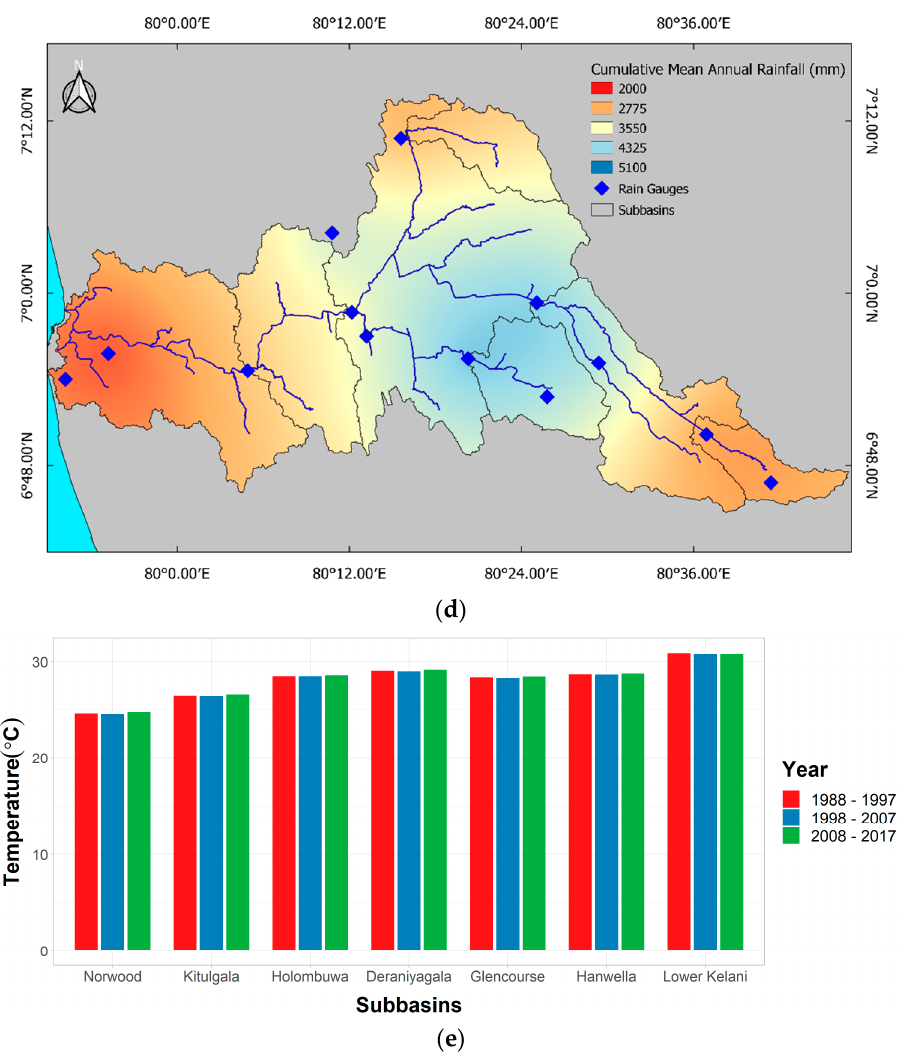
Figure 5. Average annual climatic variables of subbasins: ( a ) rainfall; ( b ) spatial distribution of rainfall 1988–1997; ( c ) spatial distribution of rainfall 1998–2007; ( d ) spatial distribution of rainfall 2008–2017; ( e ) temperature.